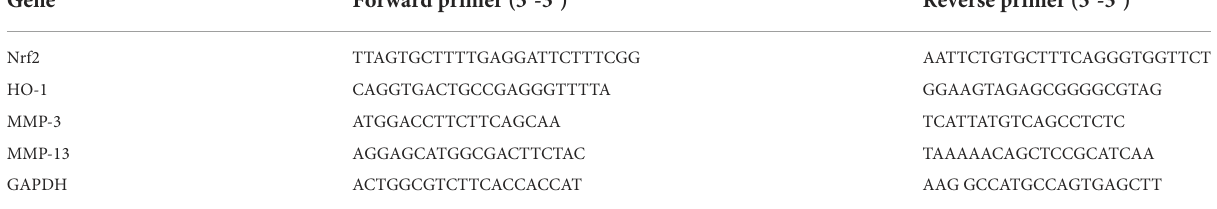
TABLE 1 The primer sequences used in qRT-PCR